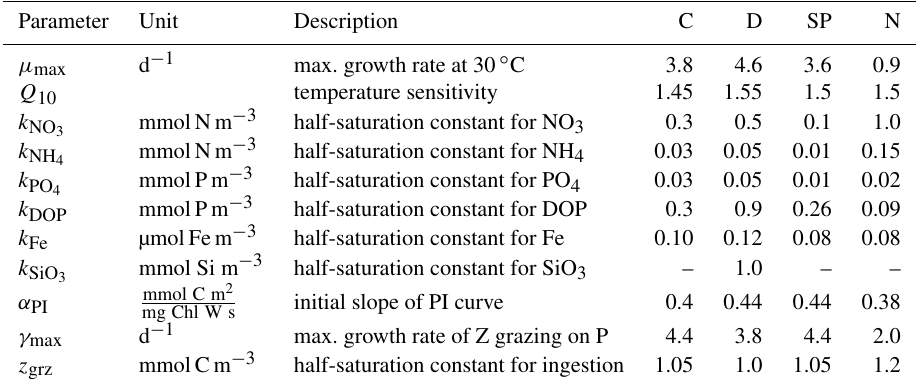
Table 1. The most relevant BEC parameters for this study as used in the reference run (see Sect. 2.2) for the four phytoplankton PFTs coccolithophores (C), diatoms (D), small phytoplankton (SP), and diazotrophs (N). Z: zooplankton, P: phytoplankton, PI: photosynthesis– irradiance.